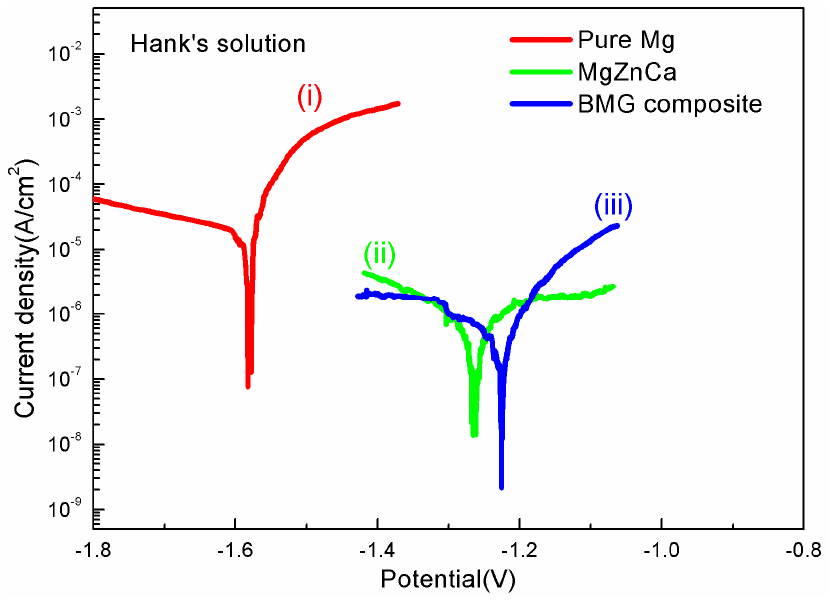
Figure 4. Potentiodynamic polarization curves of ( i ) pure magnesium; ( ii ) base alloy and ( iii ) BMG composite.